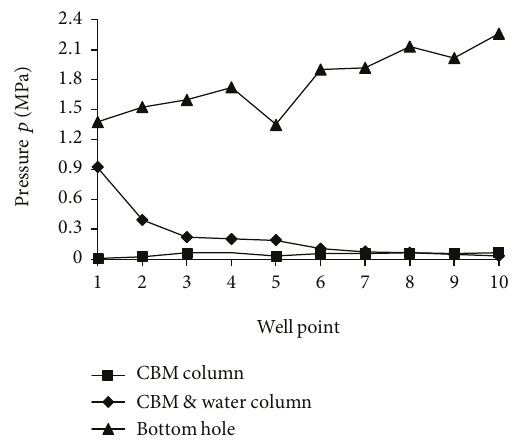
Figure 3: The variation of fl owing pressures with pumping time in two-phase producing wellbores.